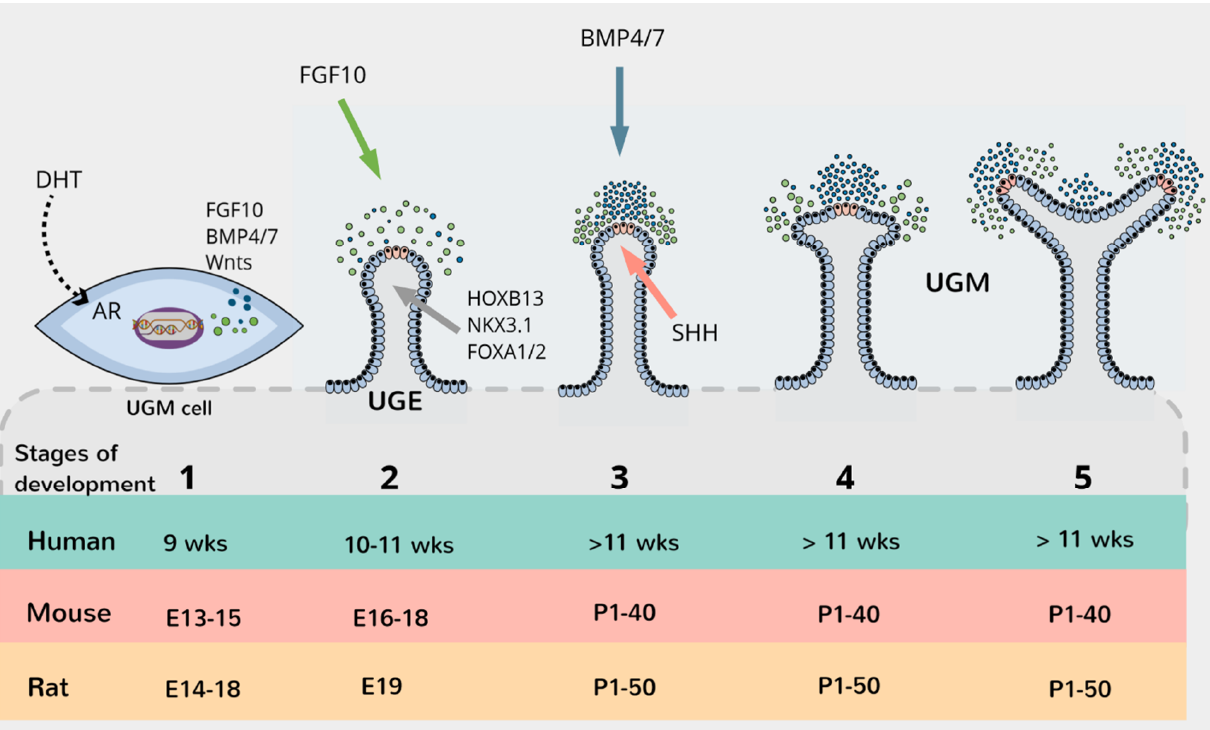
Figure 1. Prostate development. 1: pre-bud stage; 2: initial budding; 3: bud elongation; 4: branching morphogenesis; 5: branching and ductal canalisation. Solid arrows represent localisation of proteins and the dotted arrow represents movement.